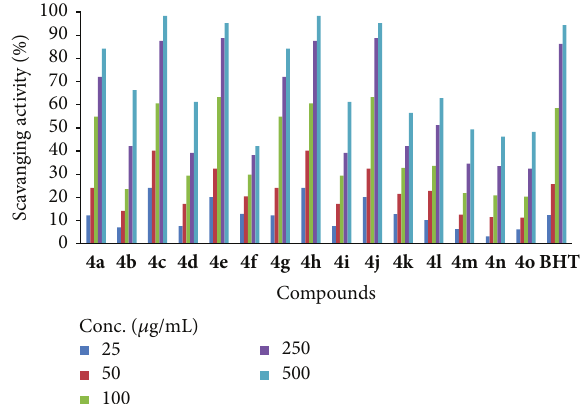
Figure 1: DPPH radical scavenging activity of the synthesized com-